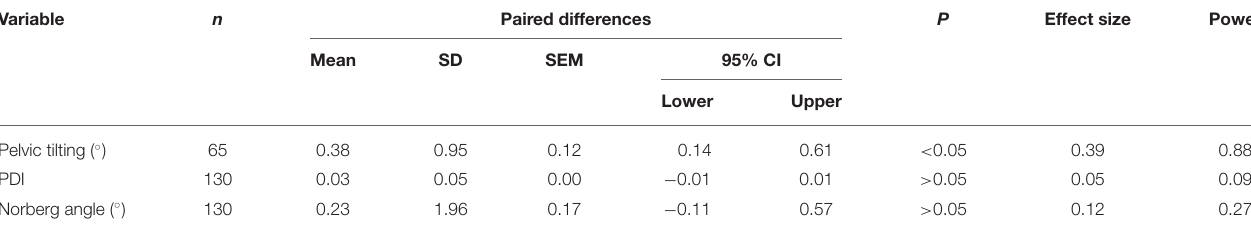
TABLE 2 | Paired variable differences between examiner and hands-free holder device dog’s positioning. Variable n Paired differences P Effect size Power